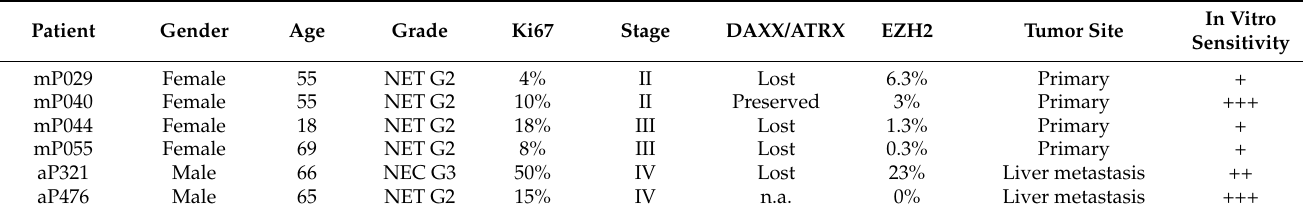
Table 2. Patient characteristics of treated islet-like